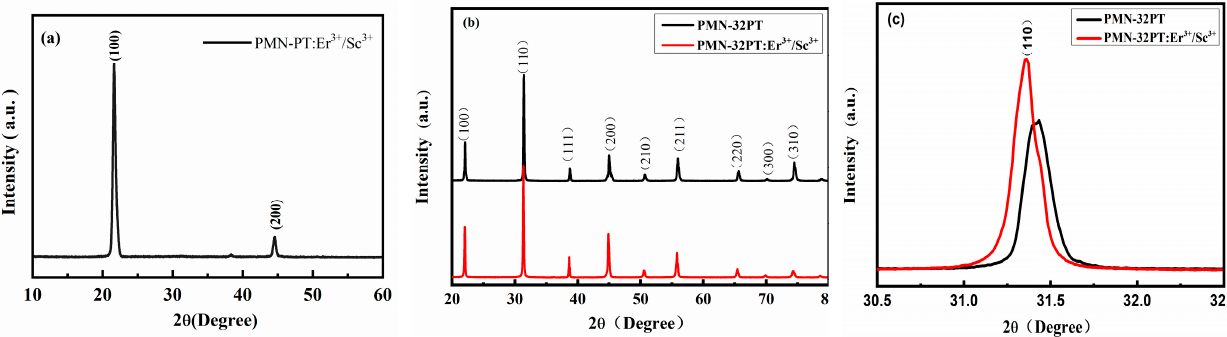
Figure 2. XRD patterns of PMN-32PT:Er 3+ /Sc 3+ ( a )platelet sample. ( b ) crystal powder ( c )zoomed XRD patterns from 30.5° to 32.5°.